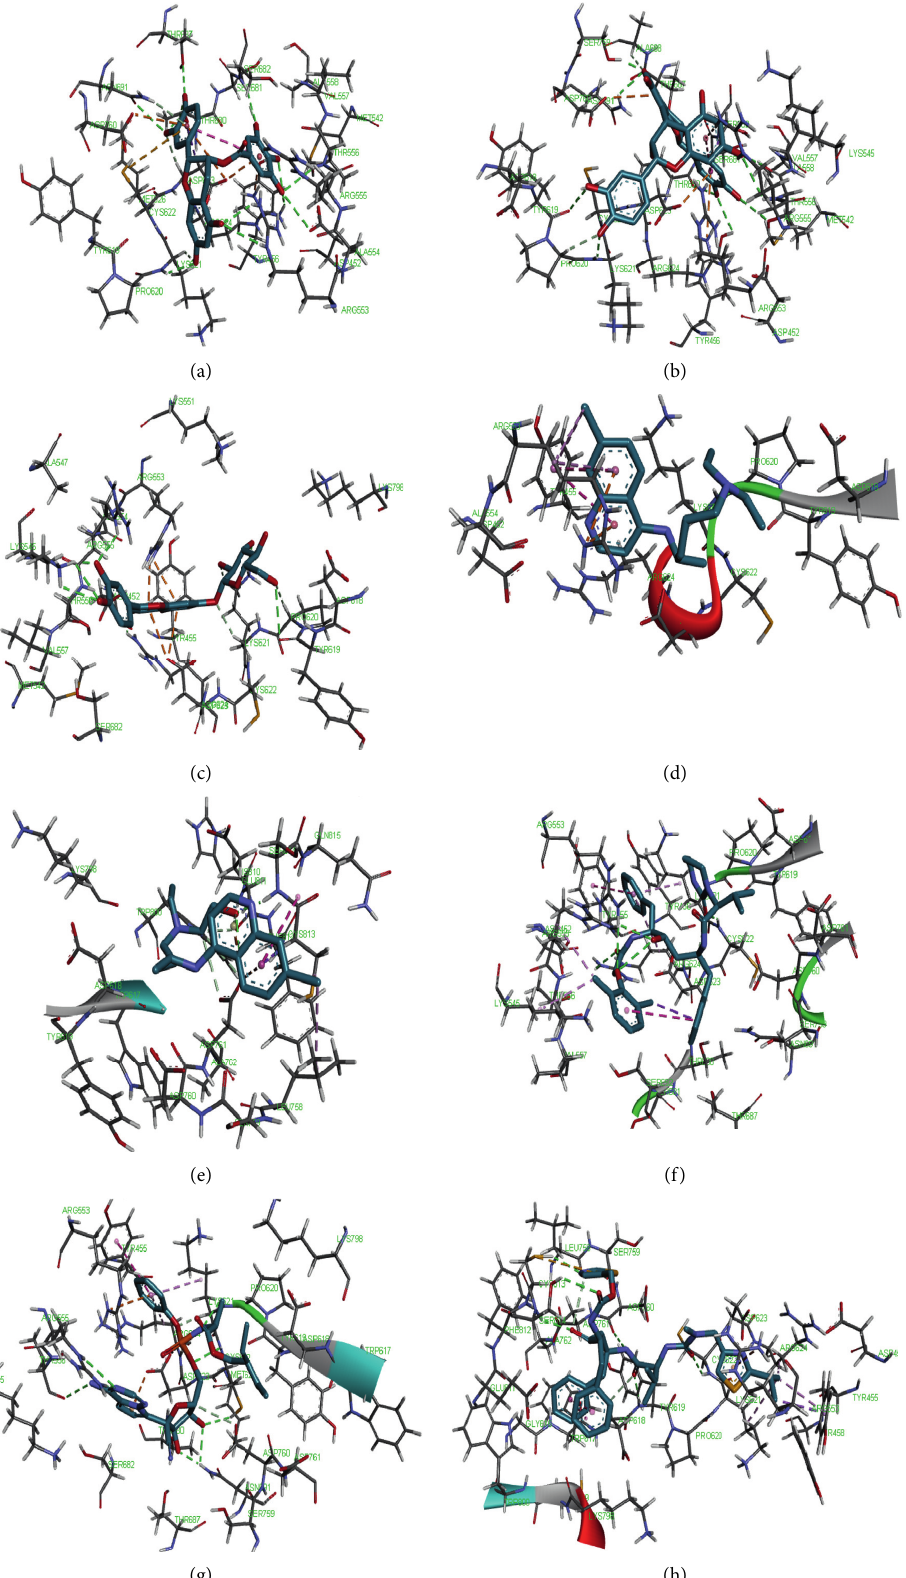
Figure 8: 3D representation of (a) 3-galloylcatechin, (b) proanthocyanidin B1, (c) luteolin 7-galactoside, (d) chloroquine, (e) hydrox- ychloroquine, (f) lopinavir, (g) remdesivir, and (h) ritonavir in the binding pocket of